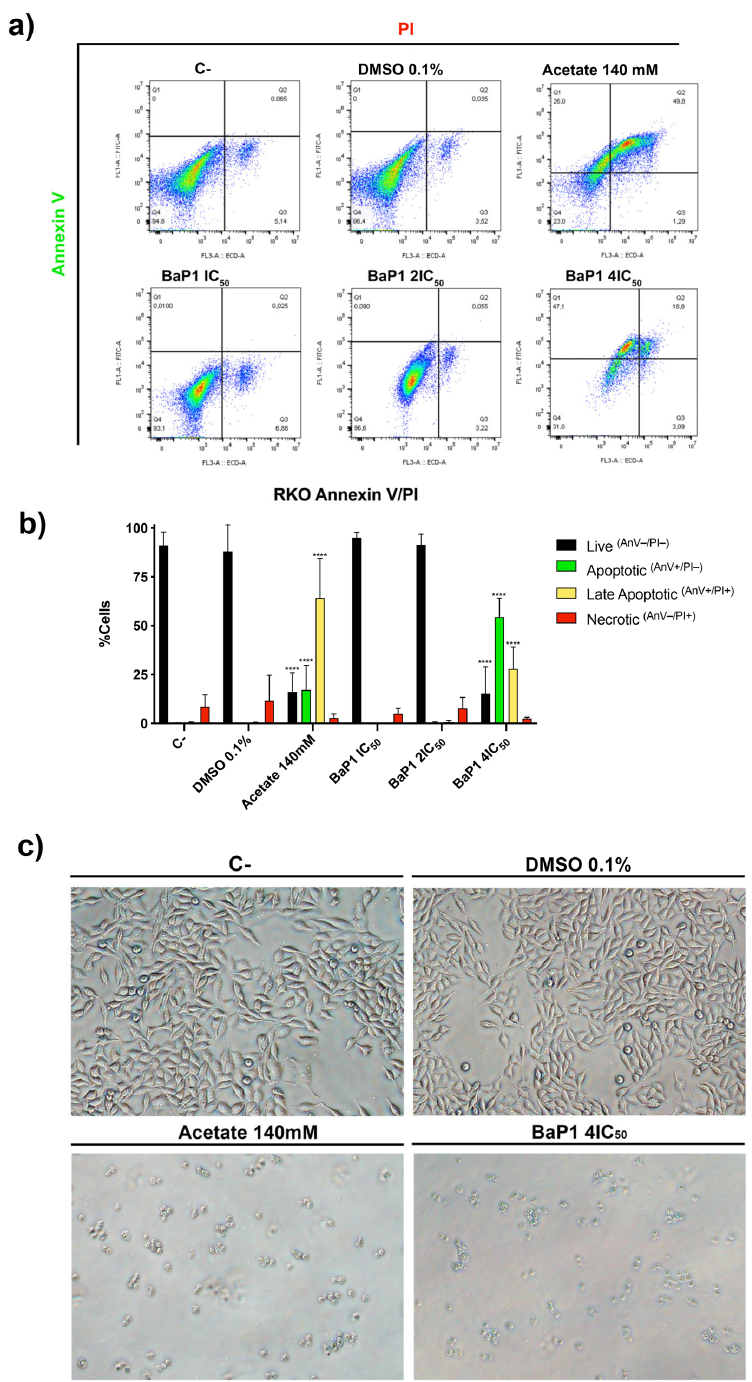
Figure 5. BaP1 cell death induction on RKO cell line. ( a ) Representative bi-parametric dot plots of RKO Annexin V/Propidium iodide (PI) analysis with Annexin V and PI after 48 h of exposure to increasing concentrations of BaP1 (IC 50 , 2 × IC 50, and 4 × IC 50 ). Untreated cells (C-) and DMSO (0.1%)